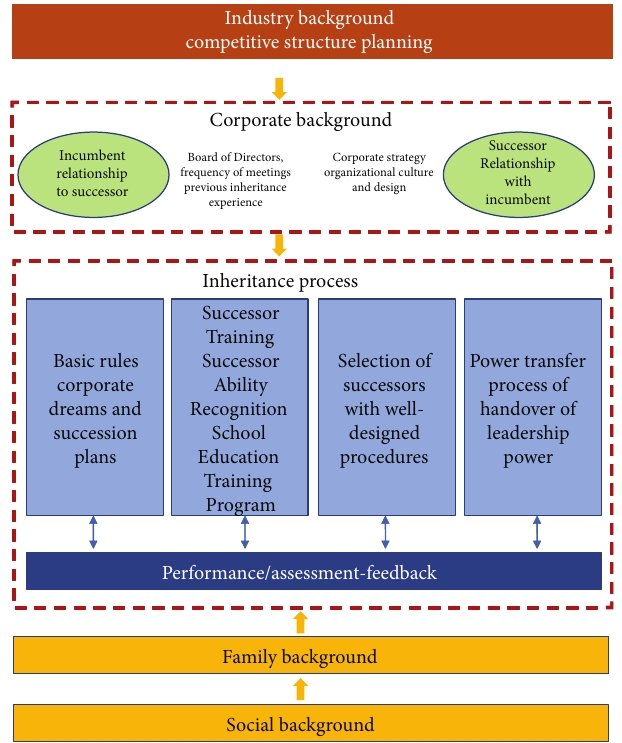
Figure 4: Comprehensive inheritance model.